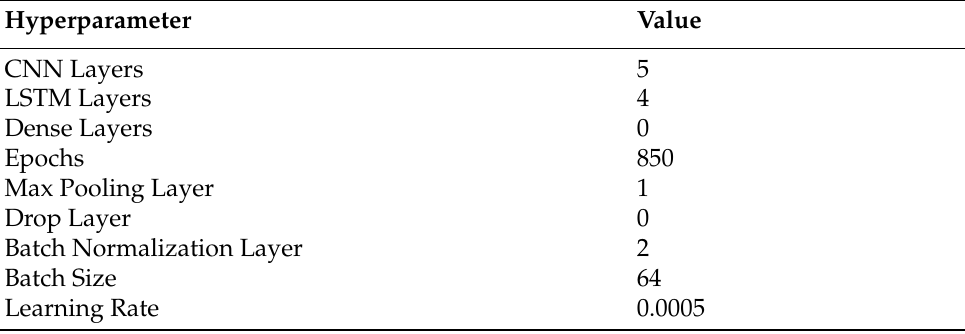
Table 6. Optimal Hyperparameters for CNN+LSTM